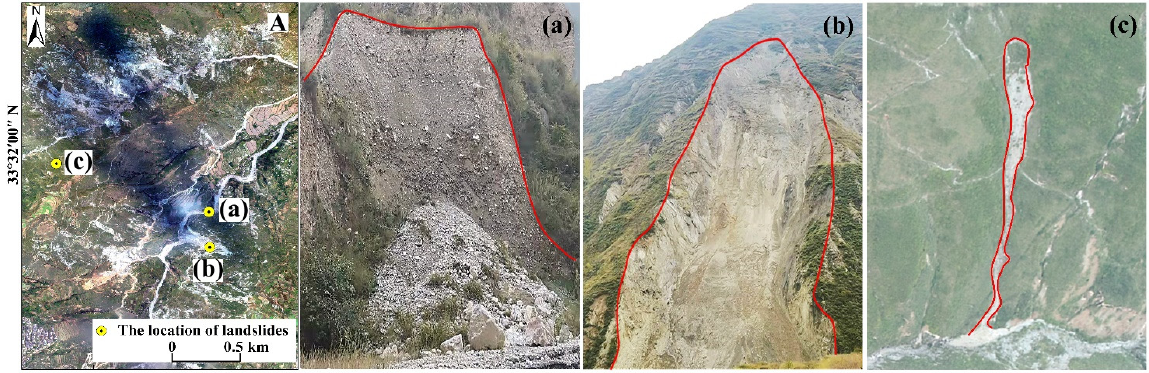
Figure 6. Classification of landslides. A : The location of landslides; ( a ) fall; ( b ) slide; ( c ) flow.